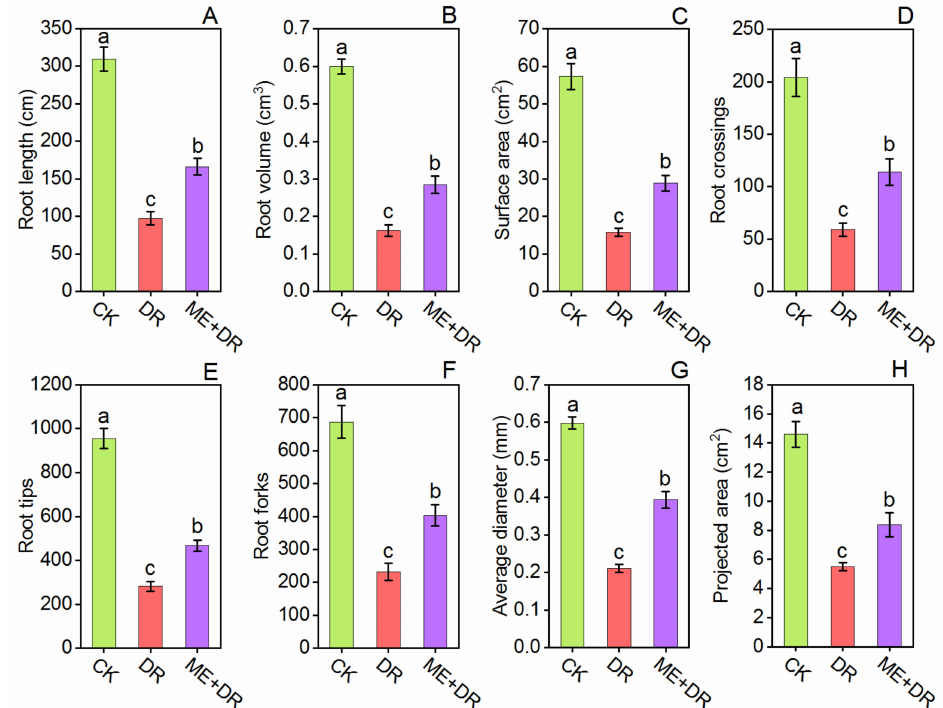
Figure 4. Exogenous supplementation of melatonin promoted root morphology [Root length ( A ), root volume ( B ), surface area ( C ), root crossings ( D ), root tips ( E ), root forks ( F ), average diameter ( G ), and projected area ( H )] of tomato seedlings under drought stress conditions. Means ± standard error, n = 3, significant difference are exhibited by lowercase letters ( p ≤ 0.05), according to LSD